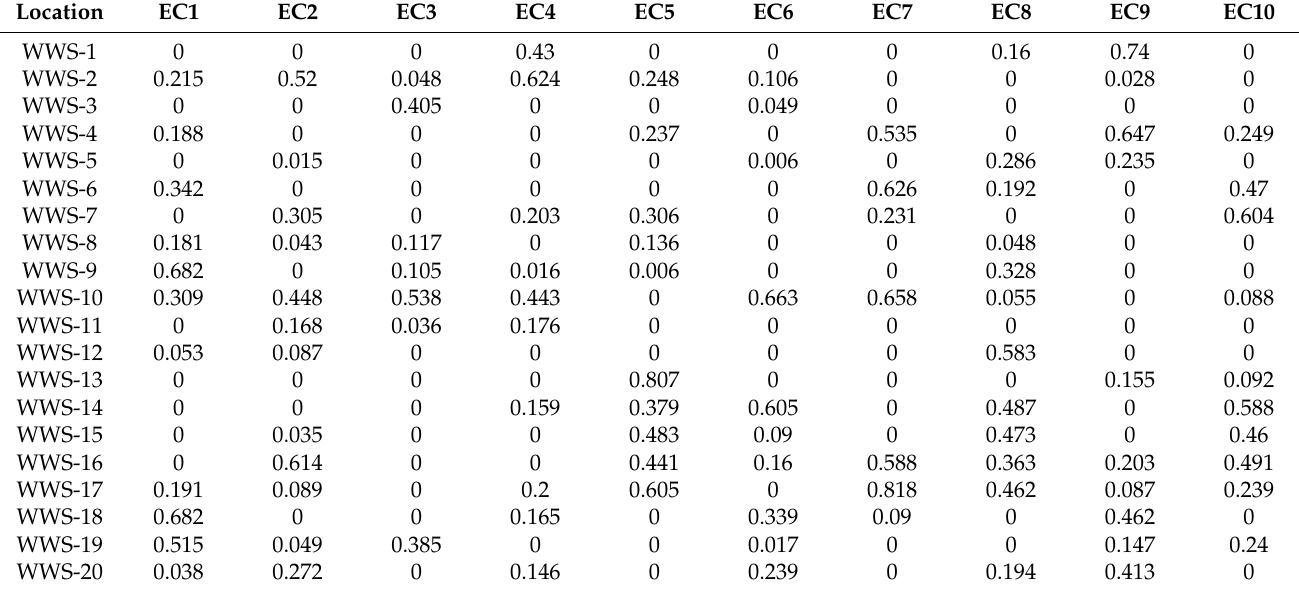
Table A10. Negative distance from average solution.